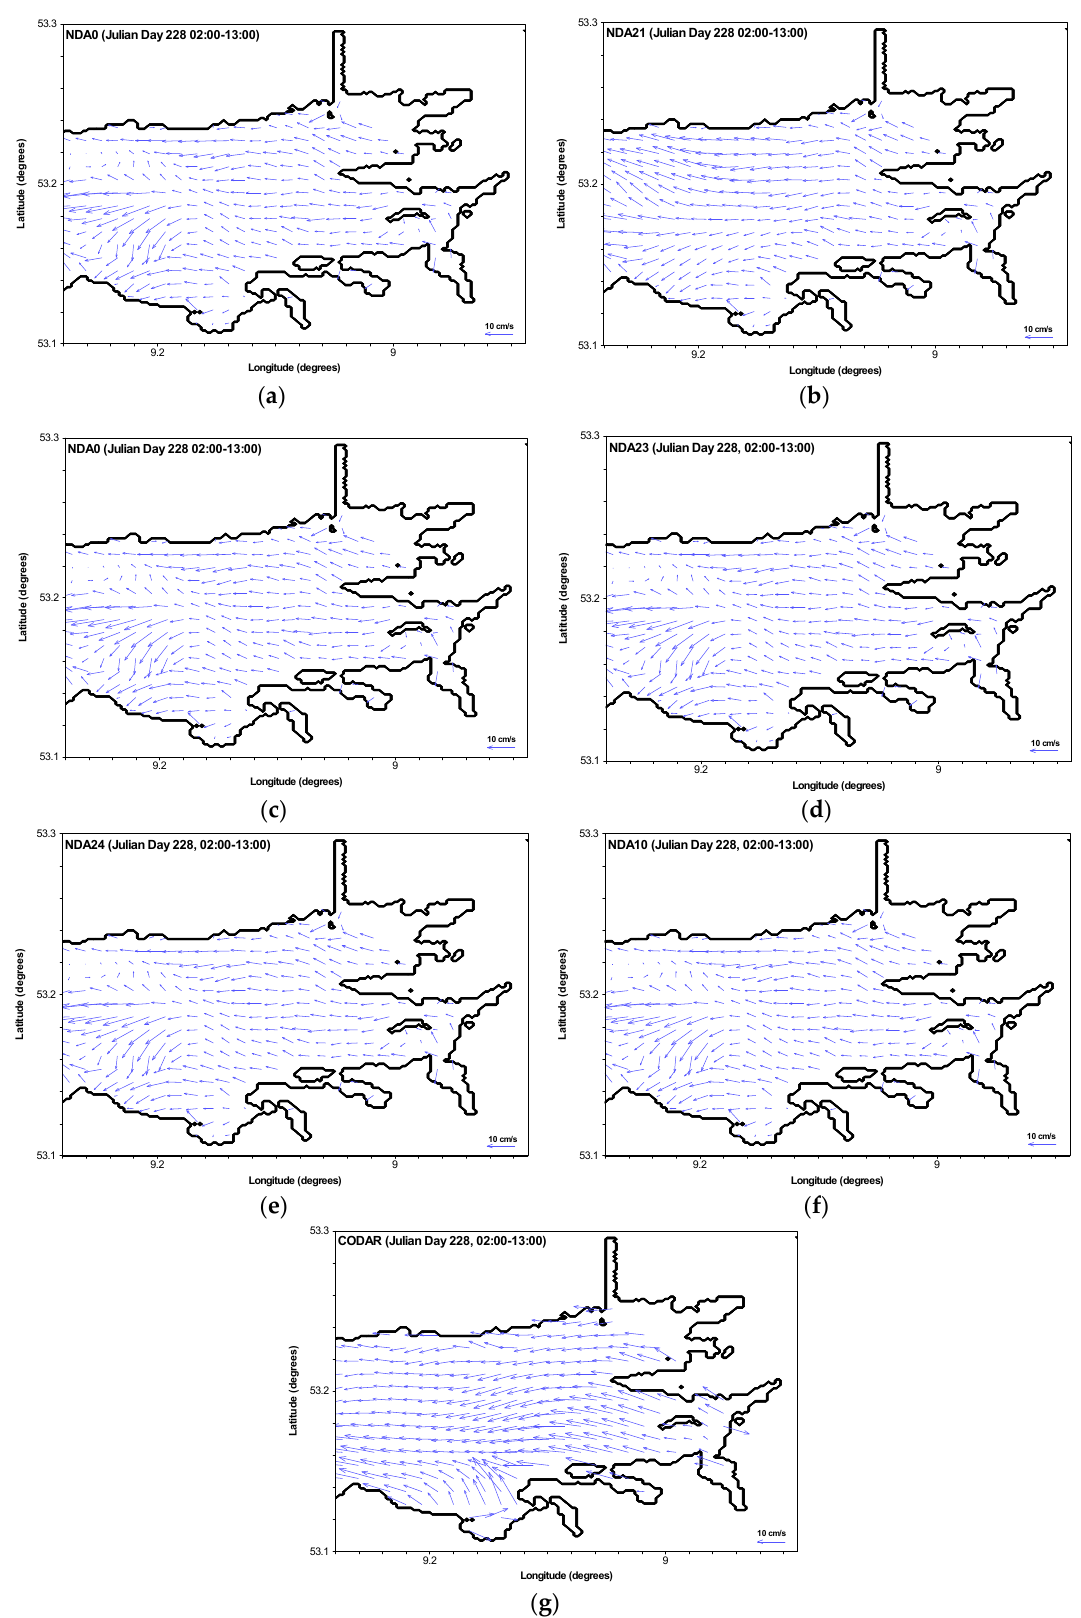
Figure 6. Mean surface flow fields (( a ) results from model NDA0; ( b – e ) results from model NDA21-NDA24, respectively; ( f ) results from model NDA10; ( g ) radar data).